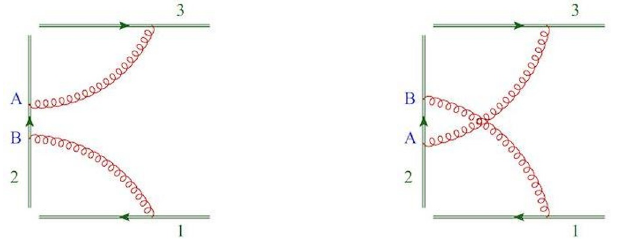
Figure 3. A simple two-loop, three-line web involving two Feynman diagrams. Note that Wilson lines are oriented, and labelled by integers in green; multiple gluon attachments to a given line (whose permutations generate the web) are labelled by capital letters in